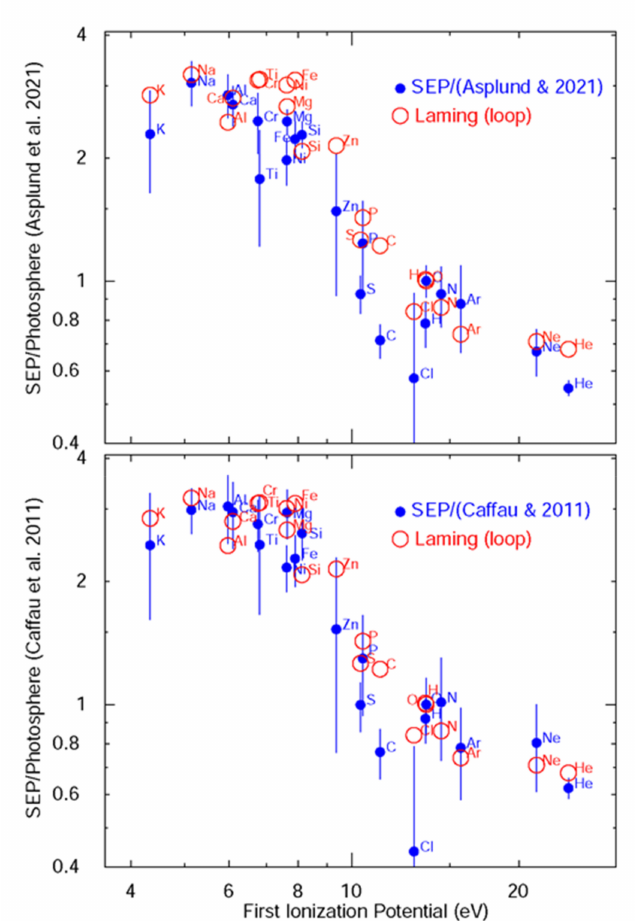
Figure 1. Average SEP abundances [6–8], relative to O, divided by the corresponding solar photo- spheric abundances [13,14] are plotted vs. FIP ( blue filled circles ) and compared with theoretical calculations [12] for closed loops ( open red circles ). Points are labeled by element